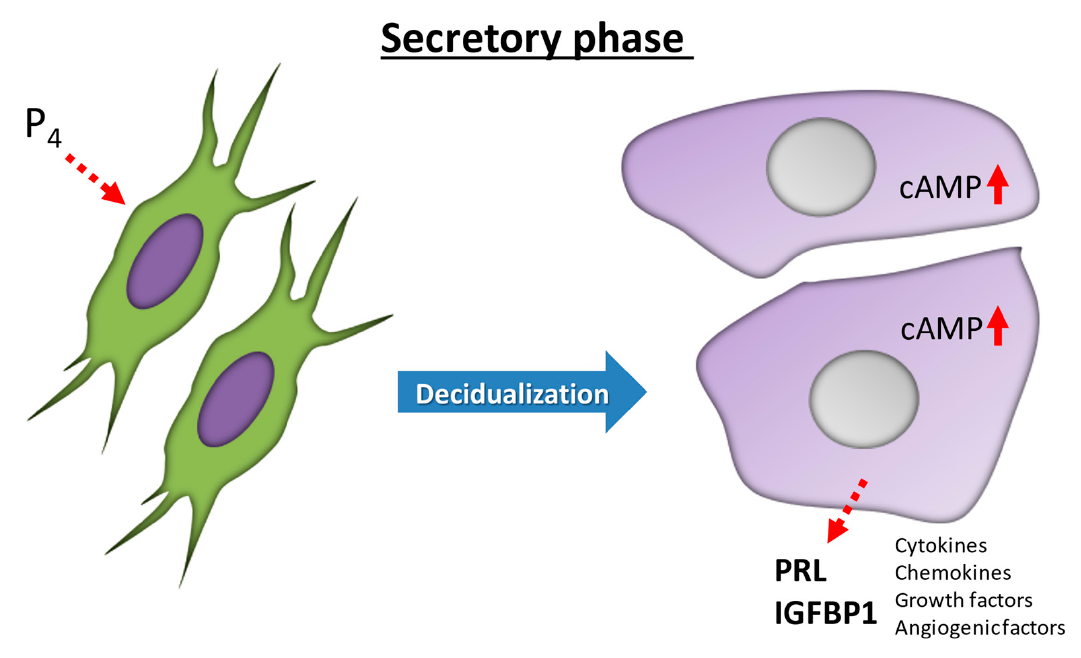
Figure 1. Differentiation in human endometrial stromal cells (ESCs) during decidualization. Decidualization is driven by increases in progesterone (P4) and then local cyclic adenosine monophosphate (cAMP) production. In the human endometrium, ESCs transform from fibroblast-like cells in the proliferative phase to epithelium-like cells with cytoplasmic expansion, large pale nuclei, and rounded shapes in the secretory phase. IGFBP-1, insulin-like growth factor binding protein-1; PRL, prolactin.